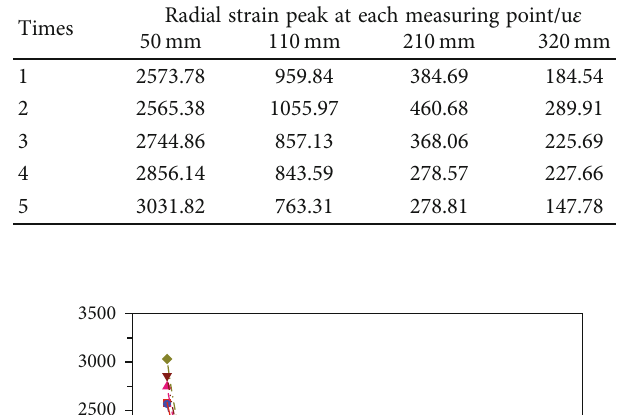
Figure 4: Pressure time history curve of HPAB. Table 4: The damage results of di ff erent points of the specimen under multiple